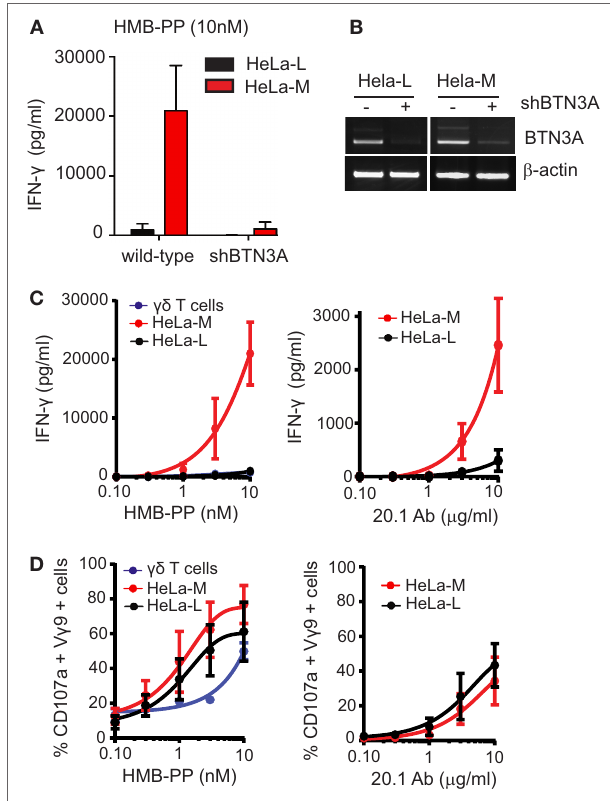
FigUre 1 | HLA haplo-identical HeLa-L and HeLa-M cells vary in their ability to present phosphoantigens to V γ 9V δ 2 T cells. (a) V γ 9/V δ 2 T cell activation as detected by production of IFN- γ . Wild-type and shRNA BTN3A HeLa-L and HeLa-M cells were pretreated with hydroxy-3-methyl-but-2-enyl pyrophosphate (HMB-PP) (10 nM for 5 h) before addition of expanded V γ 9/V δ 2 T cells at E:T ratio of 10:1. After overnight incubation, culture supernatants were analyzed by ELISA. Bar chart shows mean and SD from triplicate measurements using T cells from one donor and is representative of three independent experiments using T cells from separate donors. (B) Knockdown of BTN3A expression by shRNA expression in HeLa cells. Transcripts for BTN3A and β -actin were amplified by RT-PCR from wild-type and shRNA BTN3A HeLa-L and HeLa-M cDNA template and products analyzed by gel electrophoresis. PCR results shown are representative of three independent experiments. (c) Activation of V γ 9/V δ 2 T cells detected by ELISA for IFN- γ as in (a) using a concentration gradient of HMB-PP, agonist antibody CD277 20.1 and T cells expanded from two separate donors. Activation was induced by pretreatment of HeLa cells using HMB-PP for 5 h (left panel) and anti-BTN3A monoclonal antibody 20.1 for 30 min (right panel). Graphs show mean and SD from n = 2 and are representative of two independent measurements. (D) Activation of V γ 9/V δ 2 T cells as detected by flow cytometry for percent double positive V γ 9 and CD107a cells after coculture experiments as in (c)